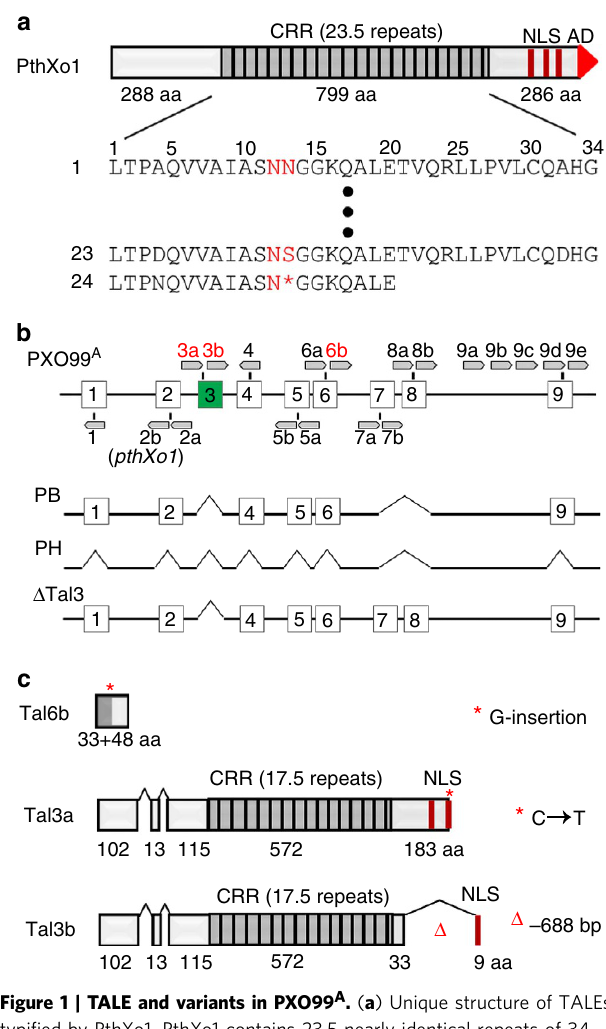
Figure 1 | TALE and variants in PXO99 A . ( a ) Unique structure of TALEs typified by PthXo1. PthXo1 contains 23.5 nearly identical repeats of 34 amino acids in the central repeat region (CRR), with polymorphic repeat variable di-residue (RVDs; two residues, in red). Single letter is used for each amino acid and the asterisk (*) denotes the missing residue. The dots represent repeats not shown. The C terminus of PthXo1 contains three NLSs and the transcription activation domain (AD). ( b ) Nine clusters (enumerated boxes) of TALE genes (pentagons, not to scale) are located in the genome of PXO99 A . Previously annotated pseudogenes (truncated genes or genes with premature stop codons, in red) are 3a, 3b and 6b. pthXo1 corresponds to 2b of cluster 2. PXO99 A mutants PB, PH and D Tal3 are cluster 3 þ 7 þ 8, all clusters and cluster 3 deleted (denoted by the carets, ^), respectively. ( c ) Three TALE variants deduced from the possible open reading frames (ORF) of three pseudogenes in PXO99 A . The asterisk (*) denotes either the insertion (for a frame-shift) or the change of C to T for a stop codon, and the caret (^) indicates the base pair deletion, relative to pthXo1